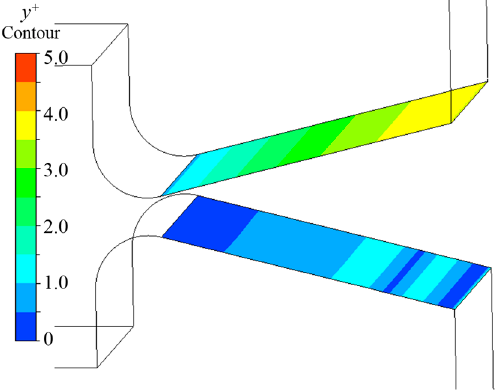
Figure 3. Calculation grids. ( a ) Local grid refinements near the edge of the diffuser throat; ( b ) Topology of the mesh.